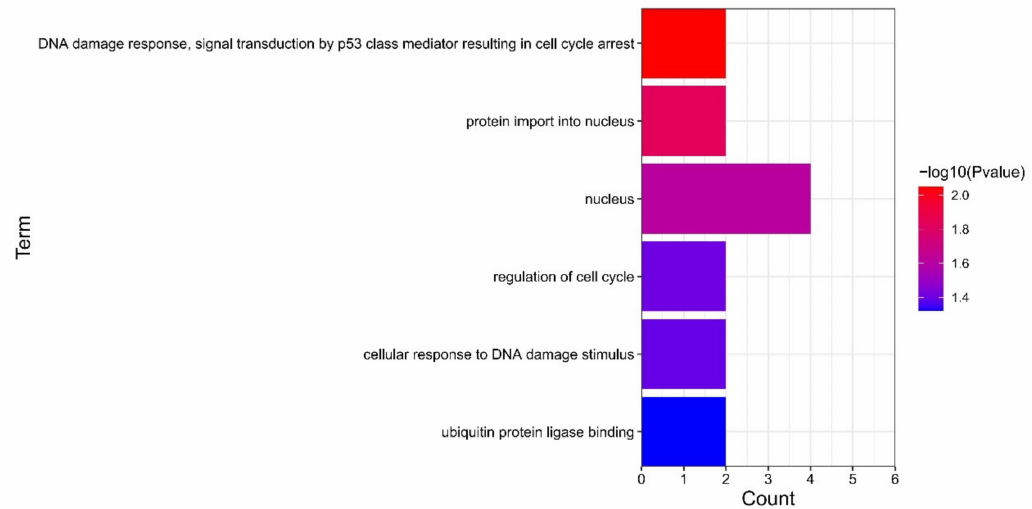
Figure 8. Significant GO terms of hub